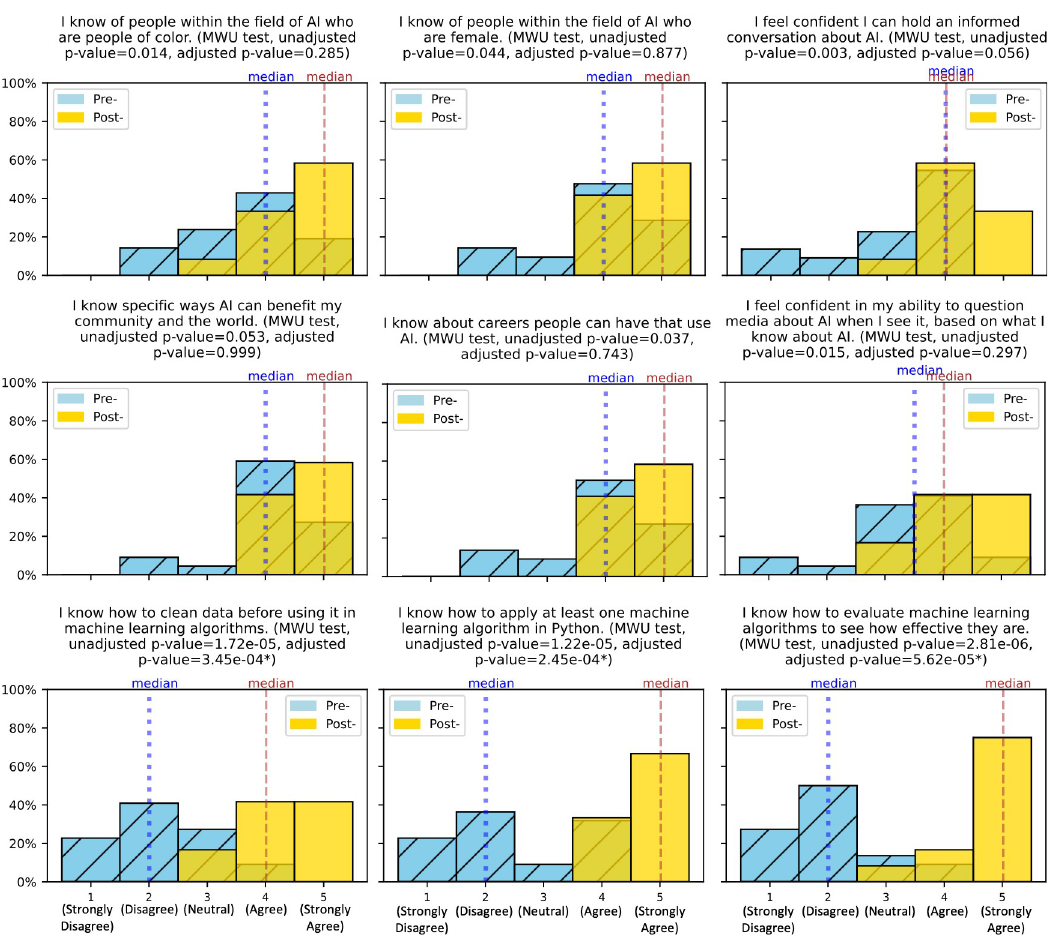
Fig 1. Pre-post survey results. Histograms of students’ responses to pre-program and post-program survey questions, with median values. Mann Whitney U tests were performed to compare pre- and post-survey responses, with adjusted p-values below significance threshold of 0.05 given an asterisk ( �